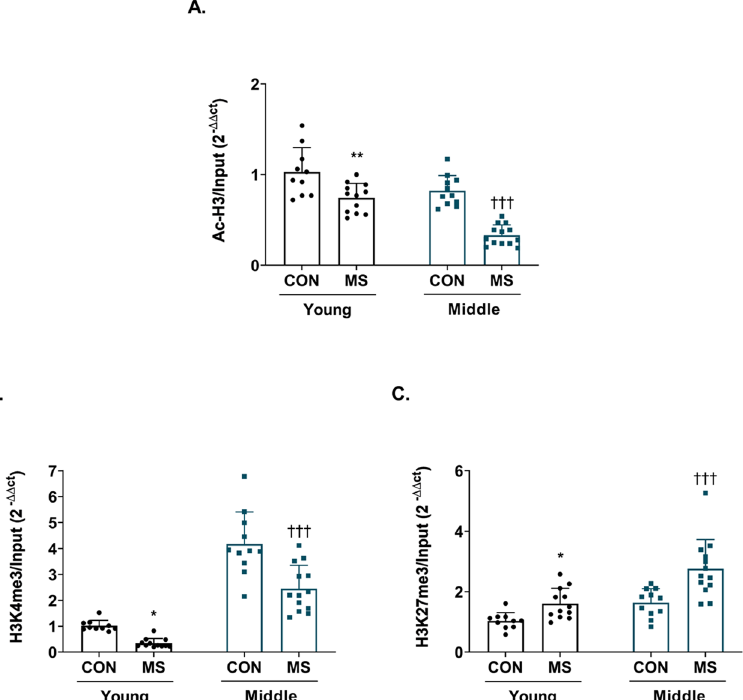
Figure 3. Alterations in histone acetylation and methylation of the hippocampal p11 promoter in young adult and middle-aged mice following MS exposure. The levels of histone H3 acetylation (AcH3, A ), histone H3 trimethylation at lysine residue 4 (H3K4me3, B ), and histone H3 trimethylation at lysine residue 27 (H3K27me3, C ) at the p11 promoter in the hippocampus were measured using a chromatin immunoprecipitation assay with antibodies to AcH3, H3K4me3, and H3K27me3. All analyses were performed on the hippocampus. Data were normalized to input DNA and are expressed as values relative mean ΔCt (control group on young adulthood) using the 2 −ΔΔCt . The data are presented as mean ± SEM ( n = 10–12/group, young adulthood; n = 11–13/group; middle adulthood). * p < 0.05 vs. control in young adulthood; ** p < 0.01 vs. control in young adulthood; *** p < 0.001 vs. control in young adulthood; ††† p < 0.001 vs. control in middle adulthood.